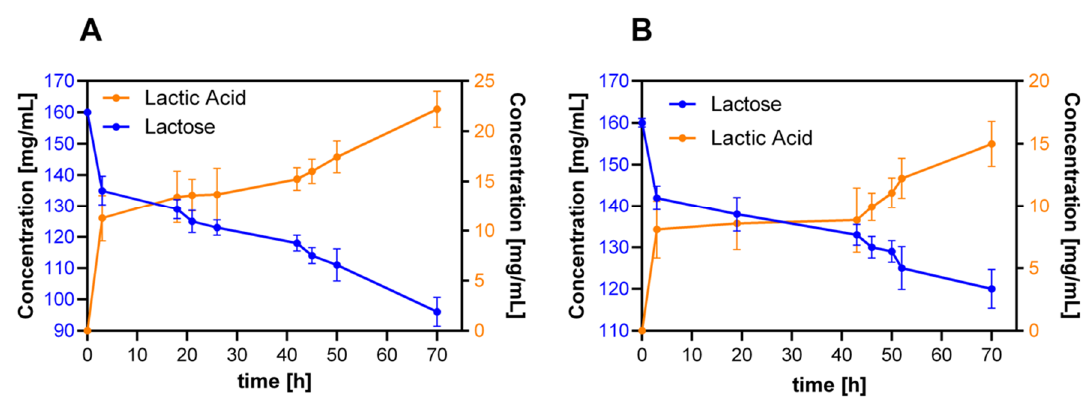
Figure 10. Proof-of-concept: milli-bioreactor production by packing 7.5% (w / v) gelatin hydrogels made with 3.0% ( A ) and 5.0% ( B ) (w / w) GTA concentration.